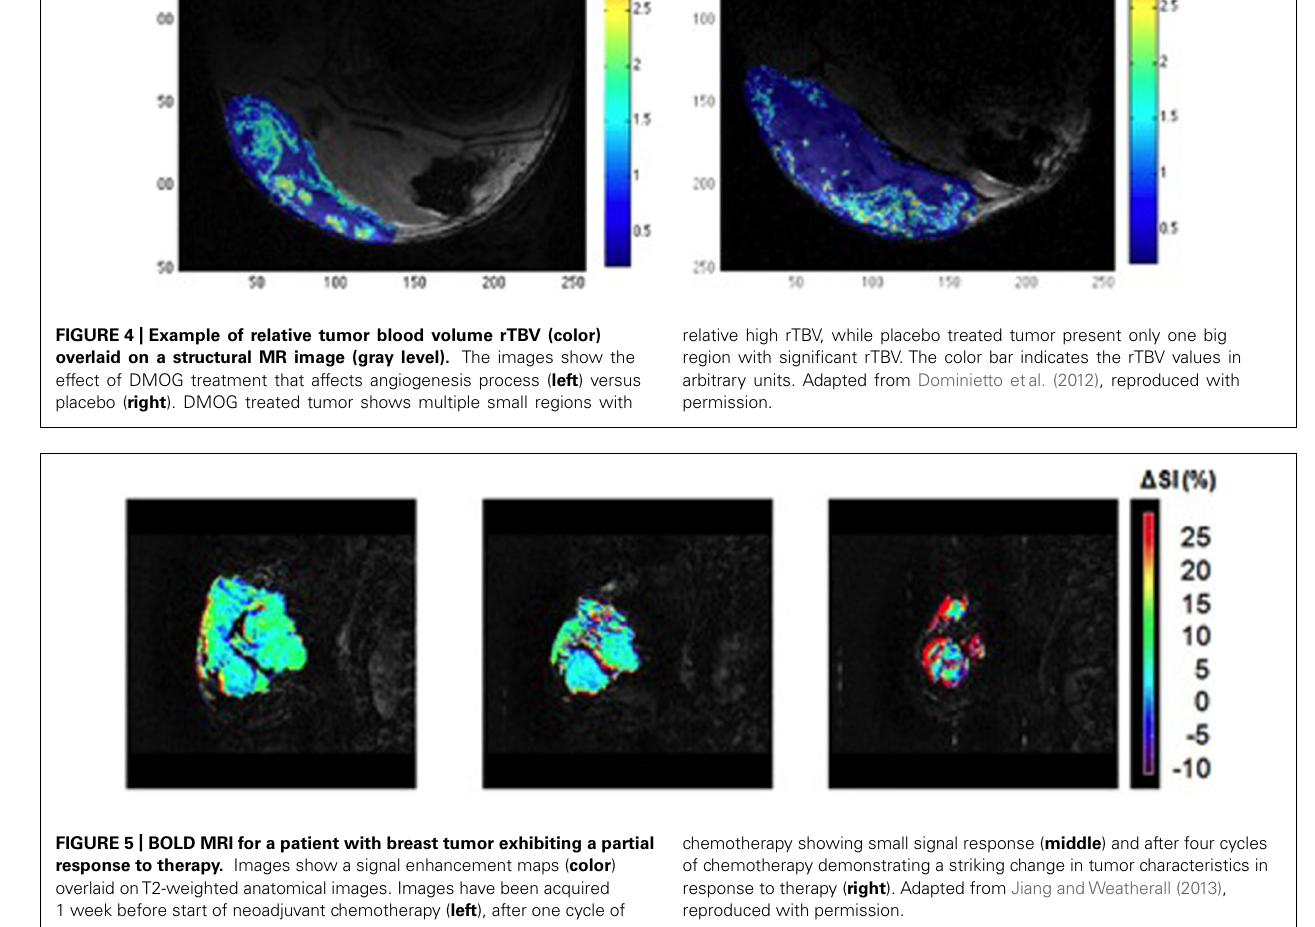
FIGURE 5 | BOLD MRI for a patient with breast tumor exhibiting a partial response to therapy. Images show a signal enhancement maps ( color ) overlaid onT2-weighted anatomical images. Images have been acquired 1 week before start of neoadjuvant chemotherapy ( left ), after one cycle of